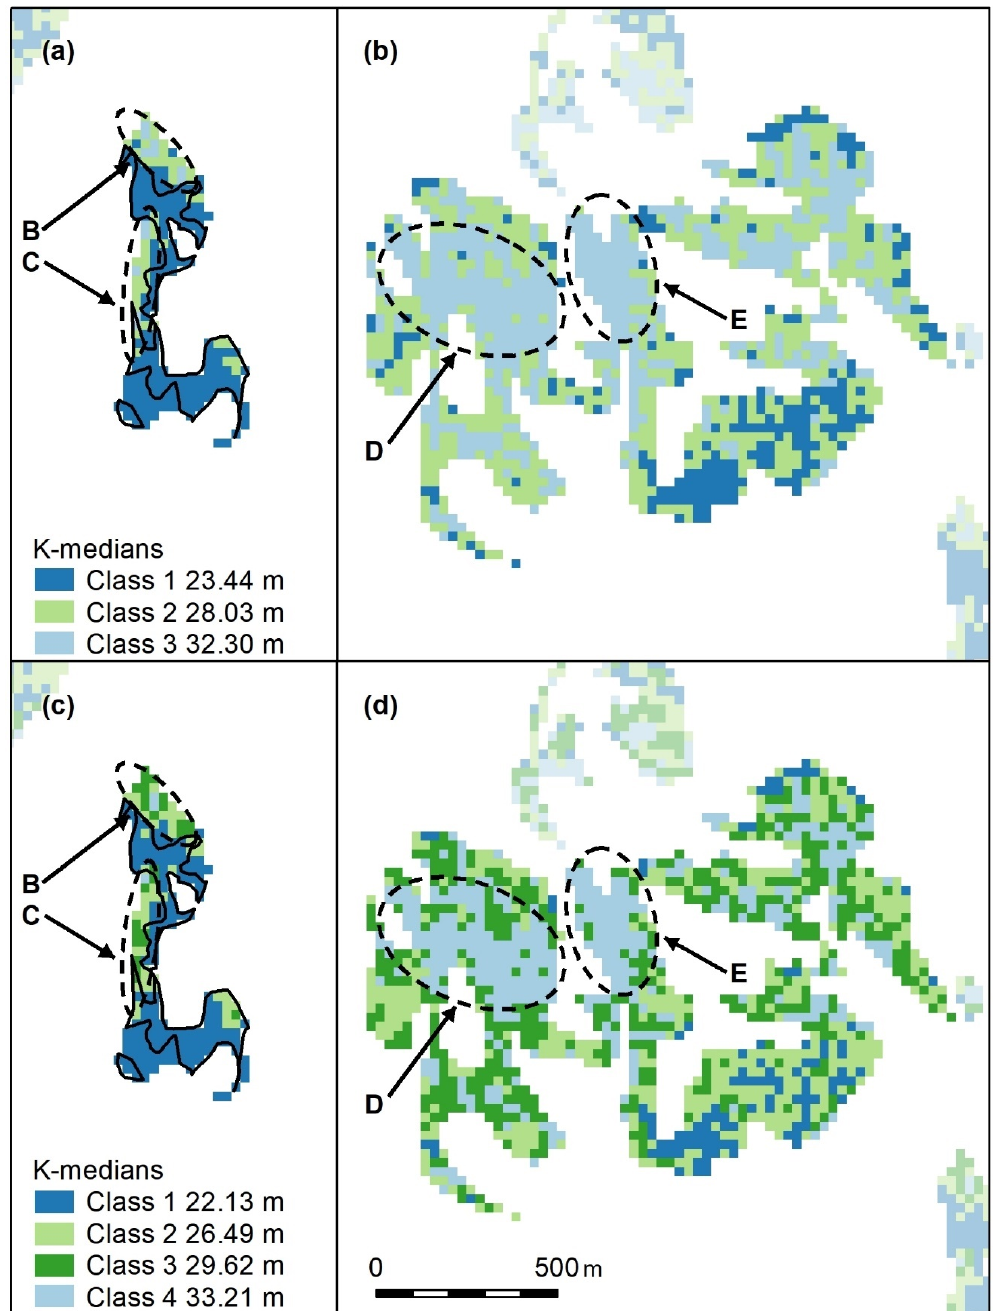
Figure 12. Nonspatial K-medians cluster maps for the Group 6 (low canopy) polygon ( a , c ) and Group 7 (high canopy) polygon ( b , d ) using all the height data from Koala Coast subregional Groups 1–7 (Figure 3). Letters B–E indicate areas of higher canopy as shown in Figure 9. Features D and E are clearly identified but B and C are not, because they belong to the second- and third-highest height classes across the wider Koala Coast subregion. B and C are still significantly higher than the lowest height class ( a , c , dark blue). Dark blue areas in ( a , c ) accurately capture areas of Mature Regrowth vegetation [63], outlined in black.